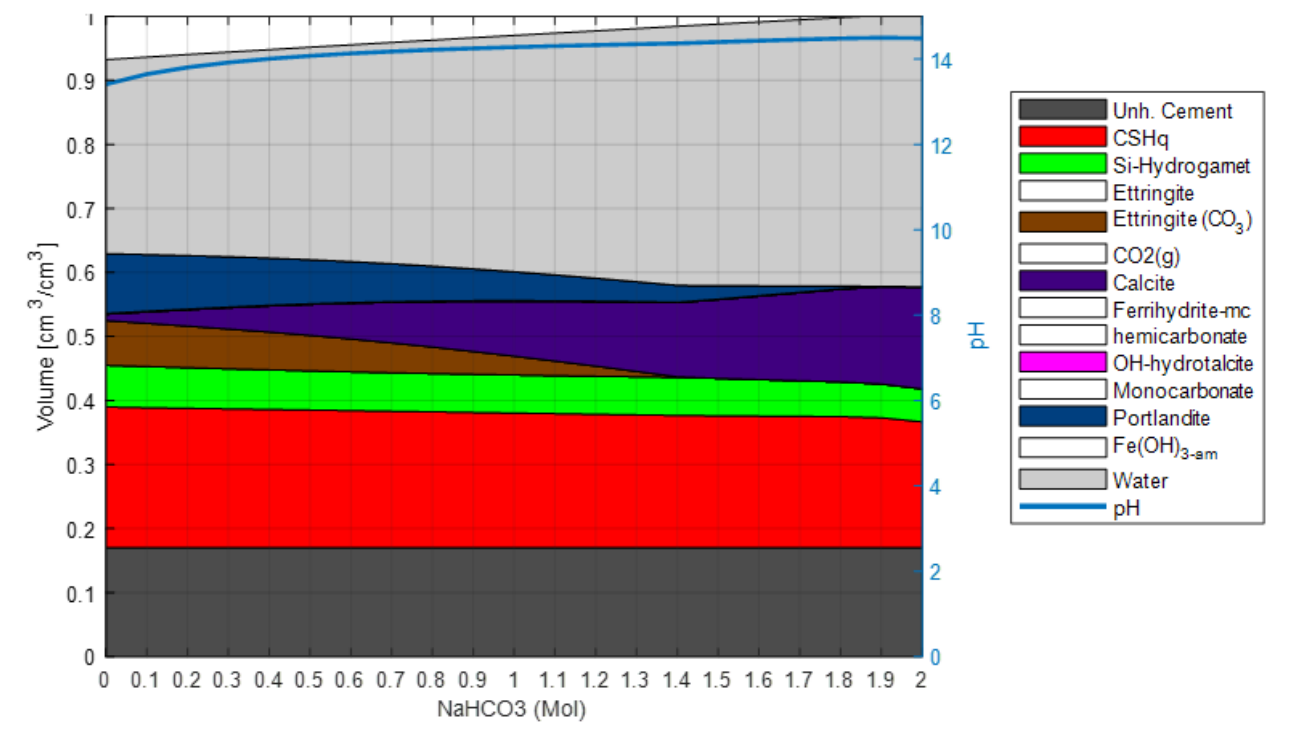
Figure 9. Validation of reaction model. Phase assemblage with increasing concentration of NaHCO 3 in exposure solution. The unhydrated cement represents the amount of unreacted cement at the time of hydration. The white blocks in the phase assembly legend indicate phases included in the chemical model, but not present at the displayed concentrations of NaHCO 3 in exposure solution.